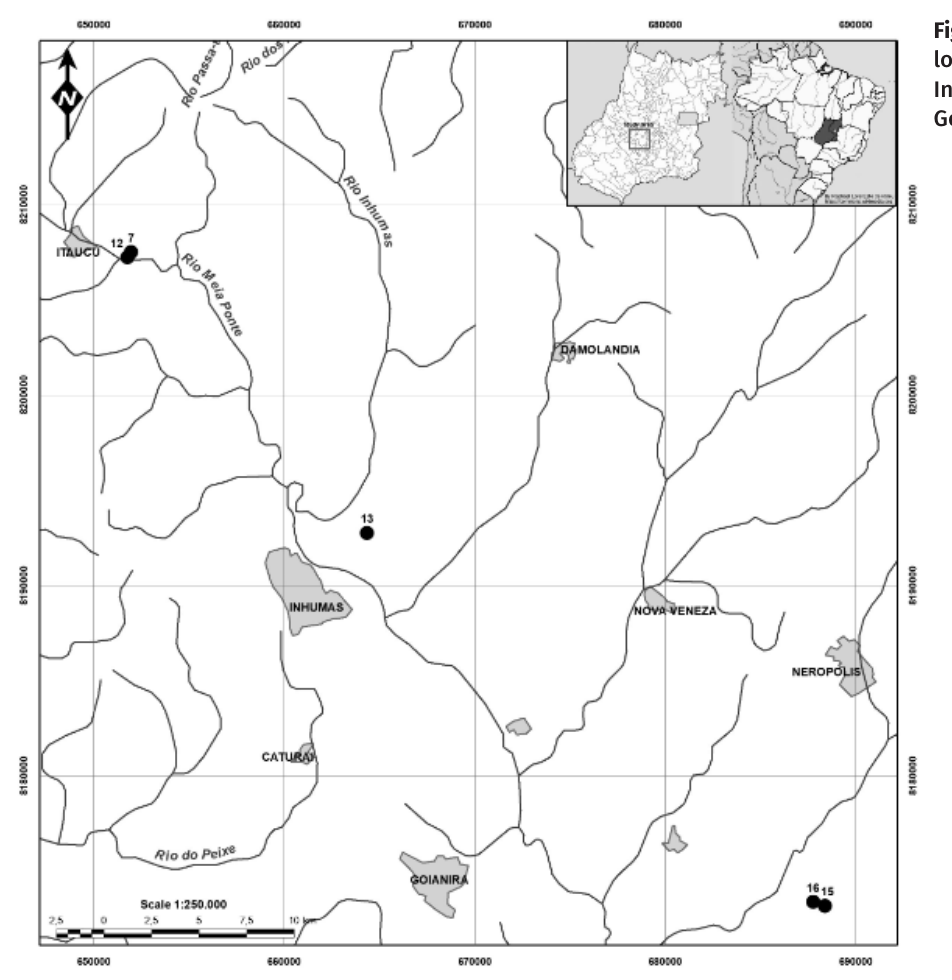
Figure 1. Map of the location of